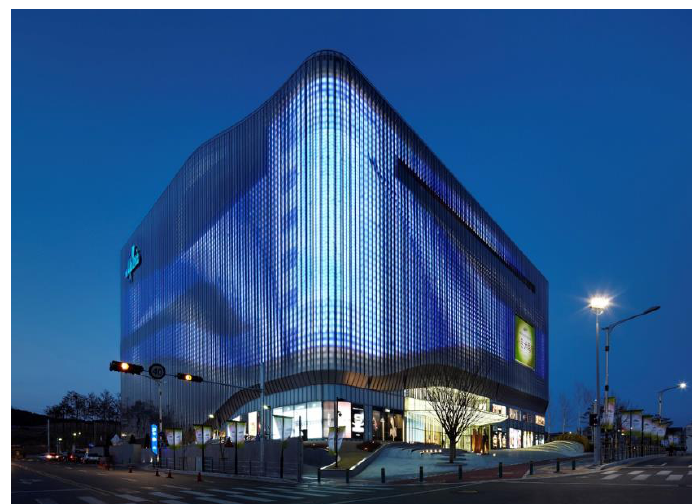
Fig. 7 Nighttime view of the Galleria Centercity. © Kim Yong-kwan.